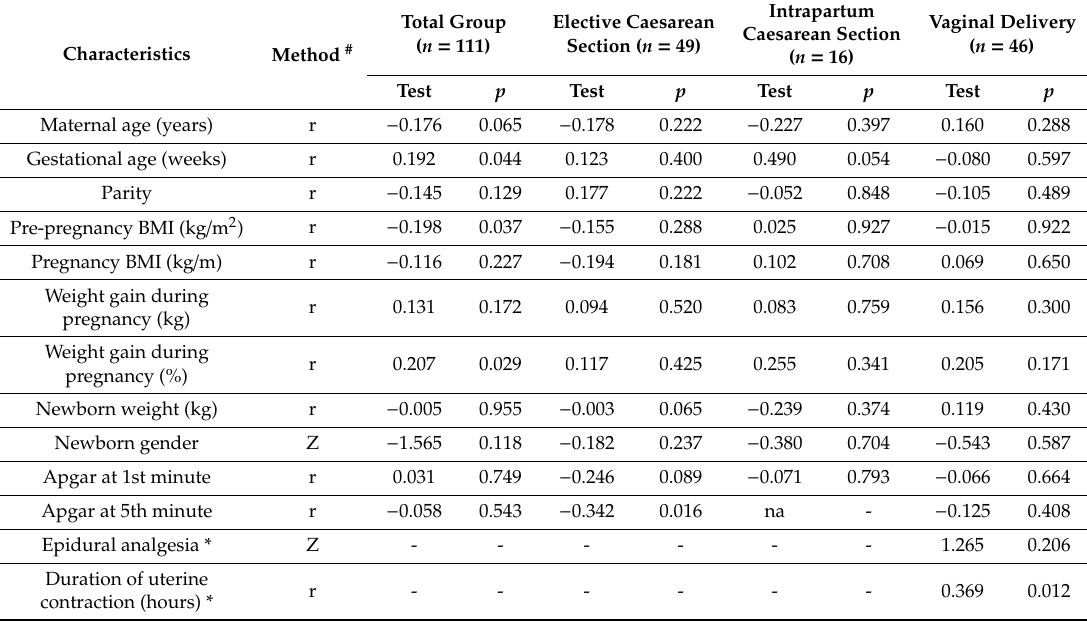
Table 3. Correlations between umbilical cord blood cortisol and maternal or o ff spring outcomes.